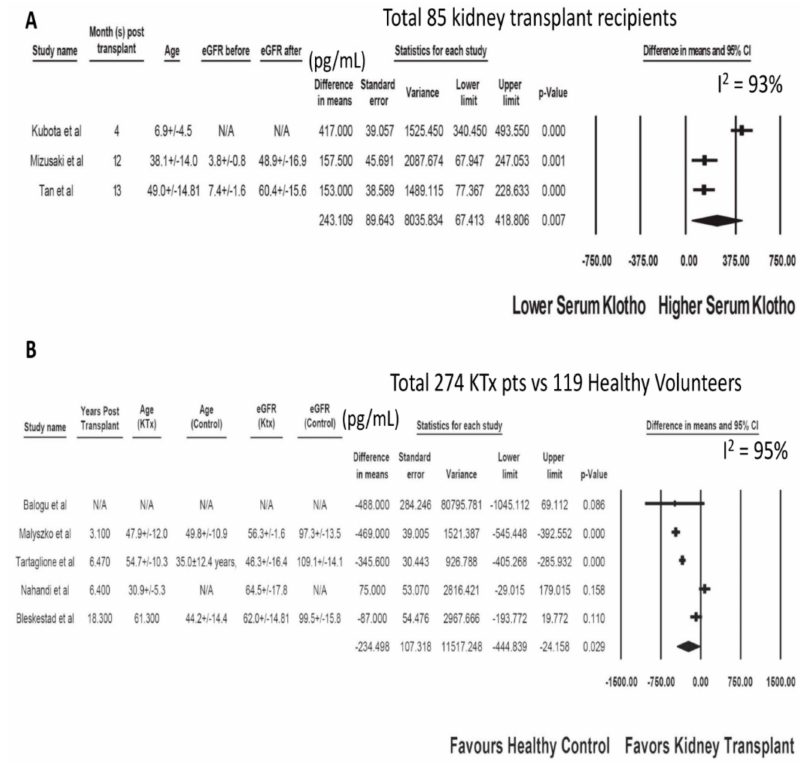
Figure 2. ( A ) Change in Serum Klotho in KTx Recipients after Kidney Transplant. ( B ) Serum Klotho in KTx Recipients Compared to Unmatched Healthy Volunteers.